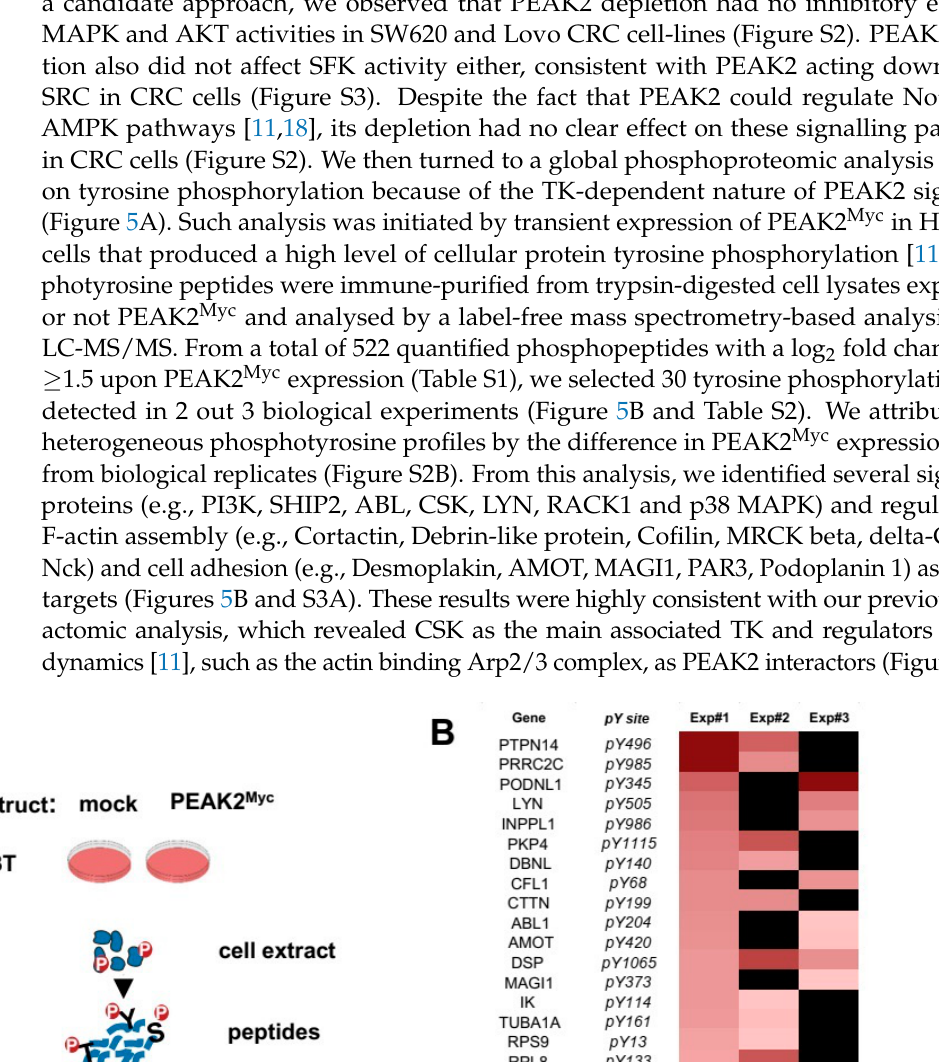
Figure 5. Phosphoproteomic analyses identified ABL as a novel PEAK2 target. ( A ) Workflow of the phosphoproteomic analysis of PEAK2 signalling in HEK293T cells. ( B ) Heatmap of phosphotyrosine peptides that show a log 2 fold change (FC) ≥ 1.5 upon PEAK2 Myc expression in 2 out 3 biological independent experiments. Missing values are shown in black. ( C ) PEAK2 induces ABL tyrosine phosphorylation and activation. ( D ) ABL induces PEAK2 phosphorylation on Y413. The levels of